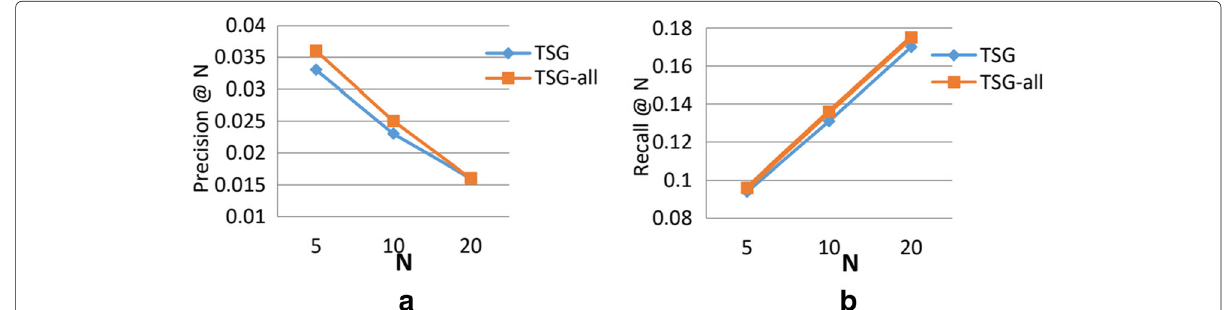
Fig. 7 The distrust influence on recommendation. a Precision@N-Foursquare. b